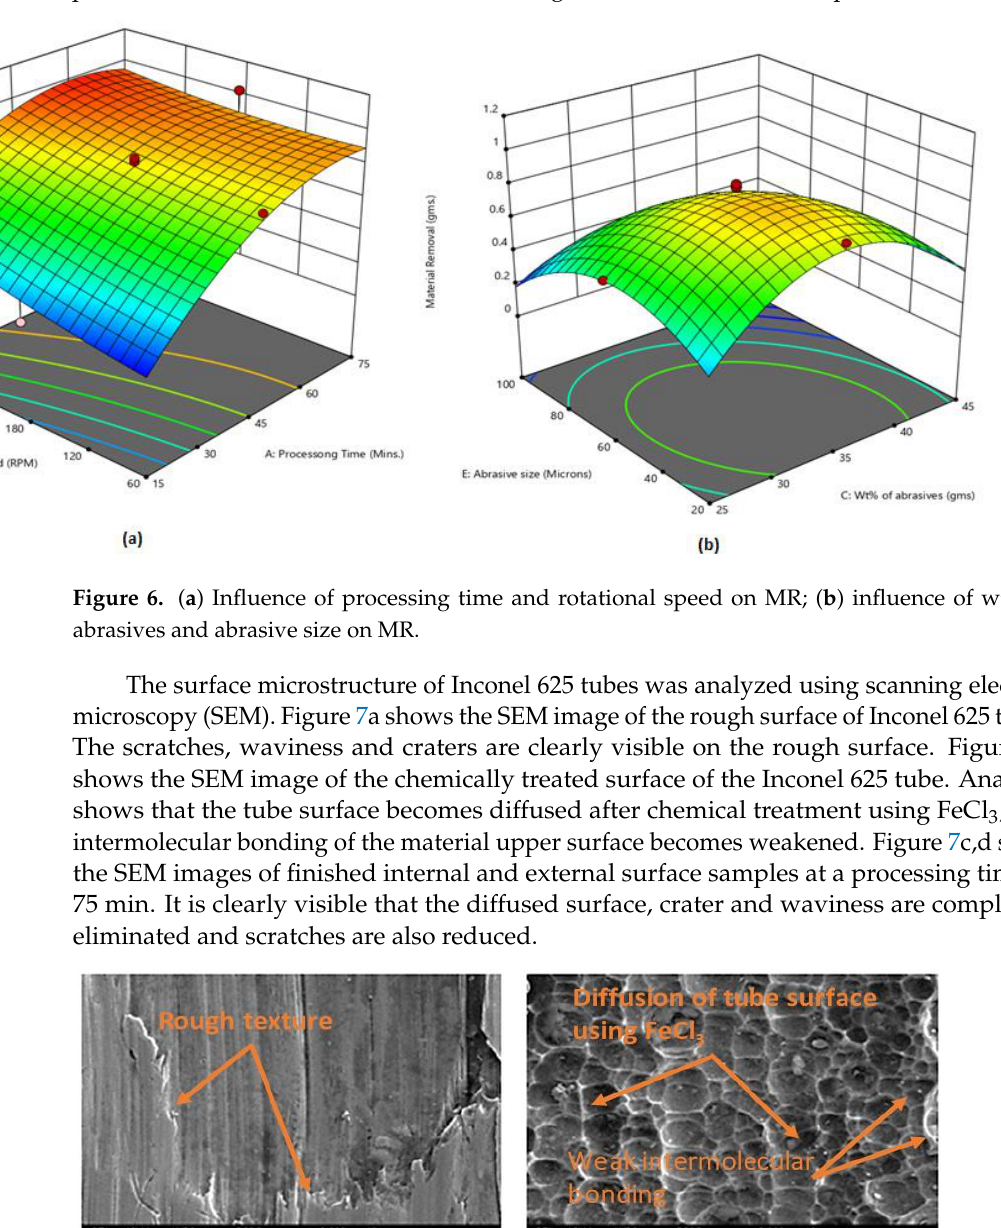
Figure 7. SEM image of Inconel 625 tube. ( a ) Rough surface; ( b ) chemically treated surface; ( c ) fin- ished internal surface (PT-75, AS-60, SRS-180, CC-600, WPS-35%); ( d ) finished external surface (PT- 75, AS-60, SRS-180, CC-600, WPS-35%). 5. Multiobjective Optimization As mentioned in preceding section, the influence of every input variable on output responses is exceptional and nonuniform. Moreover, the variable interaction is significant, and therefore it is tough to pick out best conditions for three output responses. Traditional optimization strategies cannot advise a single set of variables to obtain the best value of PIISF, PIESF and MR for the current work. Thus, there is a requirement to put into impact an advanced optimization method that might also recommend the optimal parametric settings. In present work, regression analysis is implemented, accompanied by the genetic algorithm (GA) and analytical hierarchy methods. 5.1. Regression Method The regression approach is utilized for investigating the influence of input parame- ters on output responses. Regression analysis is conducted using SPSS software. The cur- rent work is targeted on three output responses; consequently, three single-objective equations were created by utilizing the regression approach. Within the production do- main, there are various variables that have an impact on the output responses. The (d)